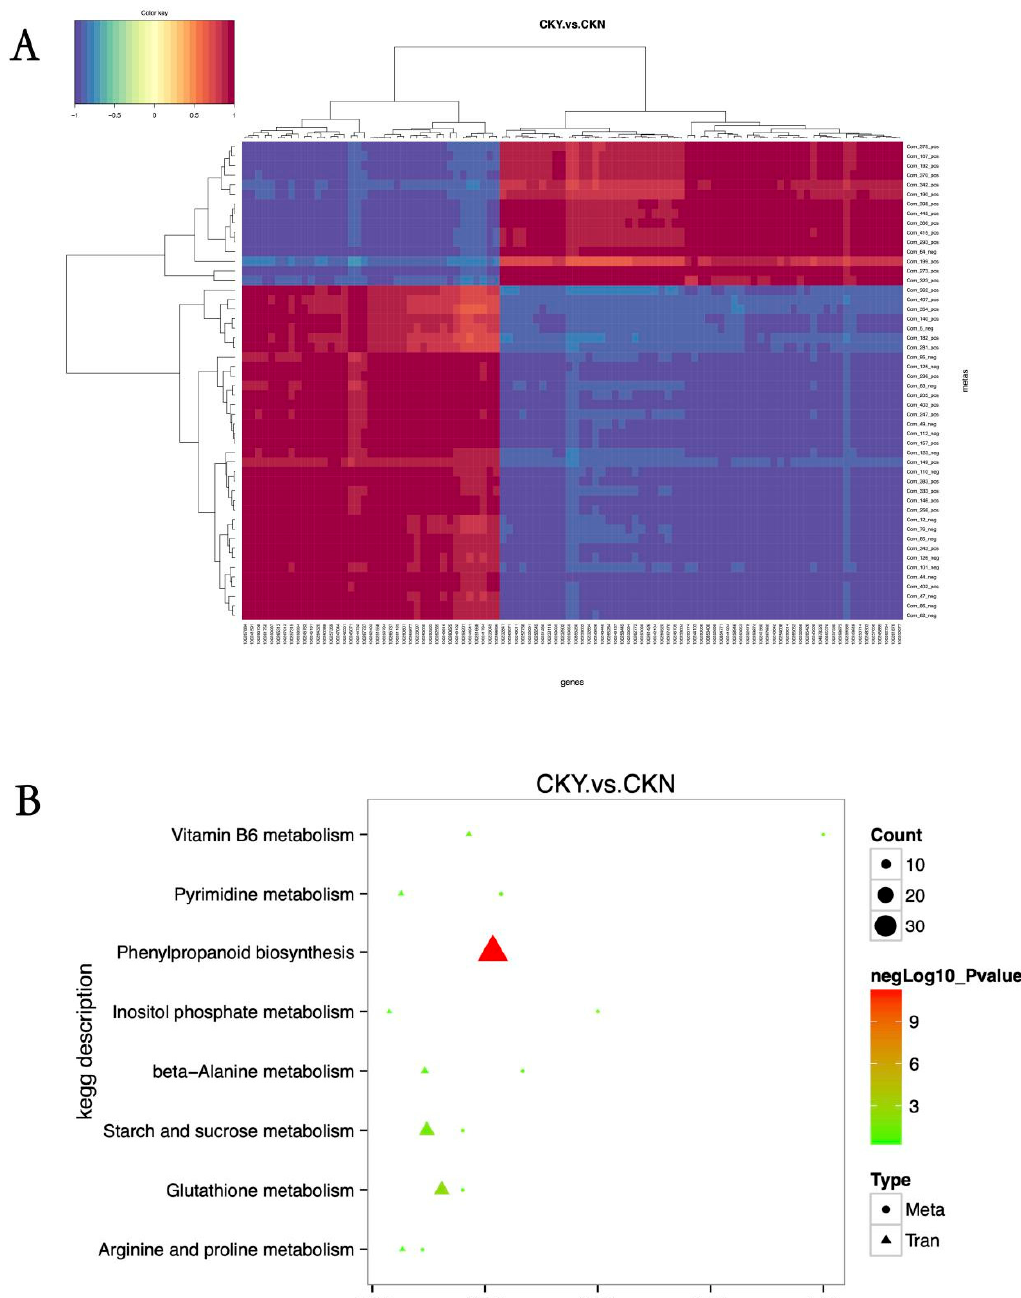
Figure 8. Association analysis between di ff erentially expressed metabolites and genes according to KEGG pathways. Correlation analysis ( A ). Correlation coe ffi cients less than 0 describe negative correlations, shown in blue, while those greater than 0 describe a positive correlation, shown in red. The branching diagram at the top of ( A ) represents clusters of di ff erentially expressed genes, while the branching diagram at the left of ( A ) represents clusters of di ff erentially expressed metabolites. The shorter the clustering branch, the higher the similarity. KEGG pathway analysis ( B ). The abscissa is the ratio of the di ff erentially expressed metabolites or genes enriched in the pathway to the number of metabolites or genes annotated in the pathway (Ratio), and the ordinate is the KEGG pathway enriched according to the metabolome–transcriptome enrichment analysis. Count is the number of metabolites or genes enriched in the